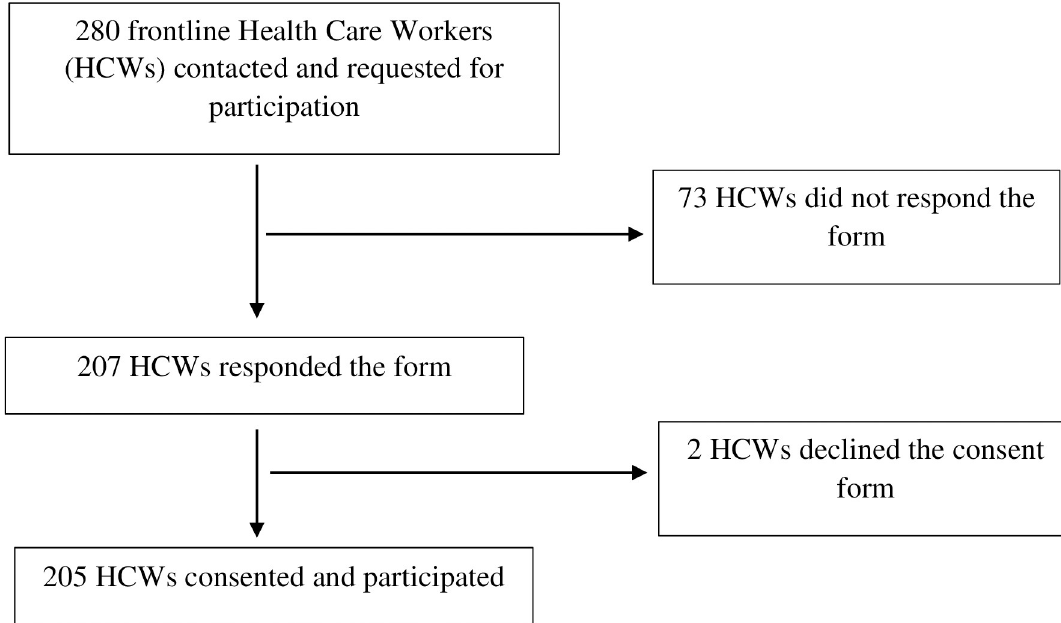
Fig 1. Flow diagram depicting study